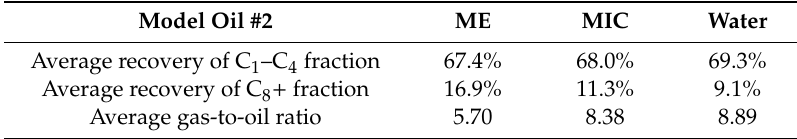
Table 2. Recovery of hydrocarbon from 3D porous kerogen model having a pore size range between 4 and 7 nm. The results are the average of five di ff erent runs on the same kerogen